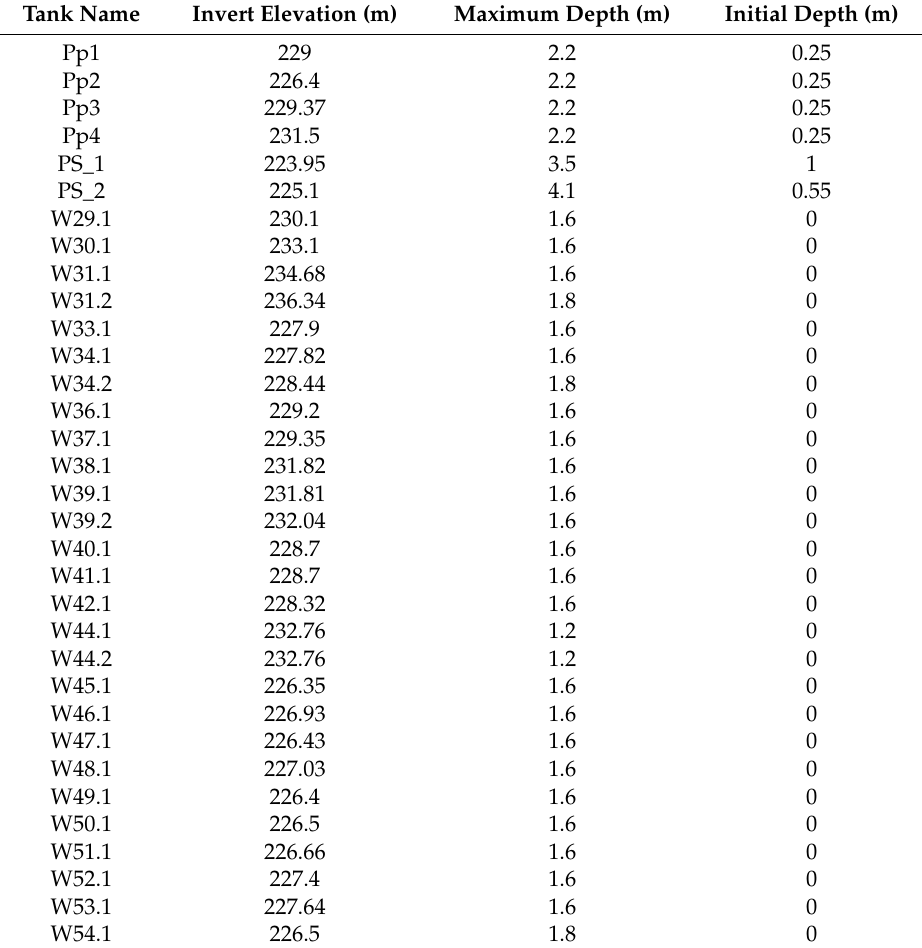
Table A3. Technical parameters of the